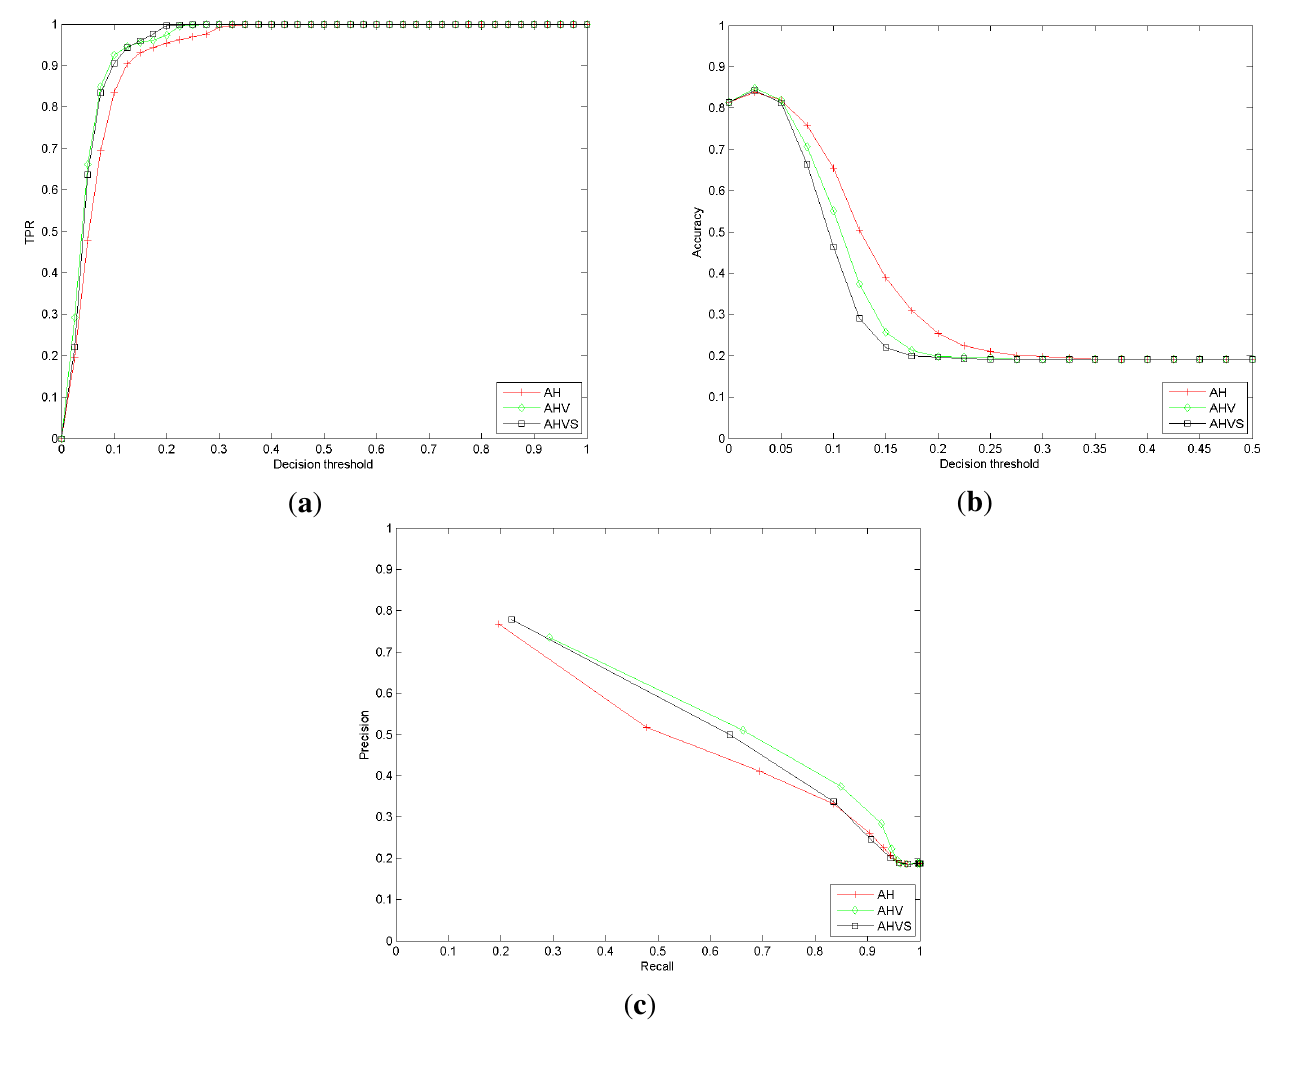
Figure 10. Cumulative Matching Curve for SequenceA